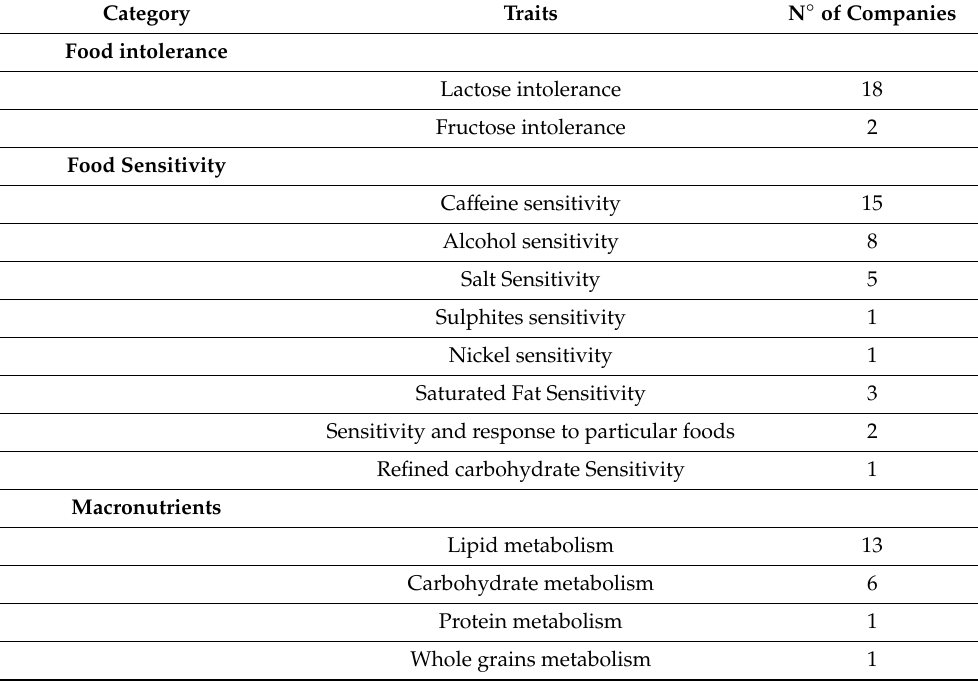
Table 3. Principal traits investigated by the selected DTC-GT companies. Number (N ◦ ) of